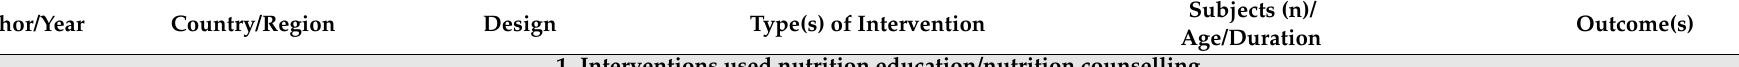
Table 3. Characteristics of the included studies reporting the effectiveness of community nutrition-specific intervention(s) for improvement of nutritional status of under five-year-old children in EMR countries: the interventions are categorized into two groups based on their main